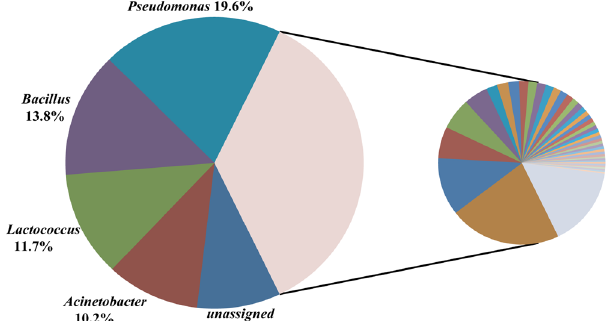
Figure 2. Illustration for four major abundant genera. All genera were showed in the pie chart. The left pie showed four major abundant genera and unsigned sequences which were not classified to genus; the right pie showed other 781 genera.